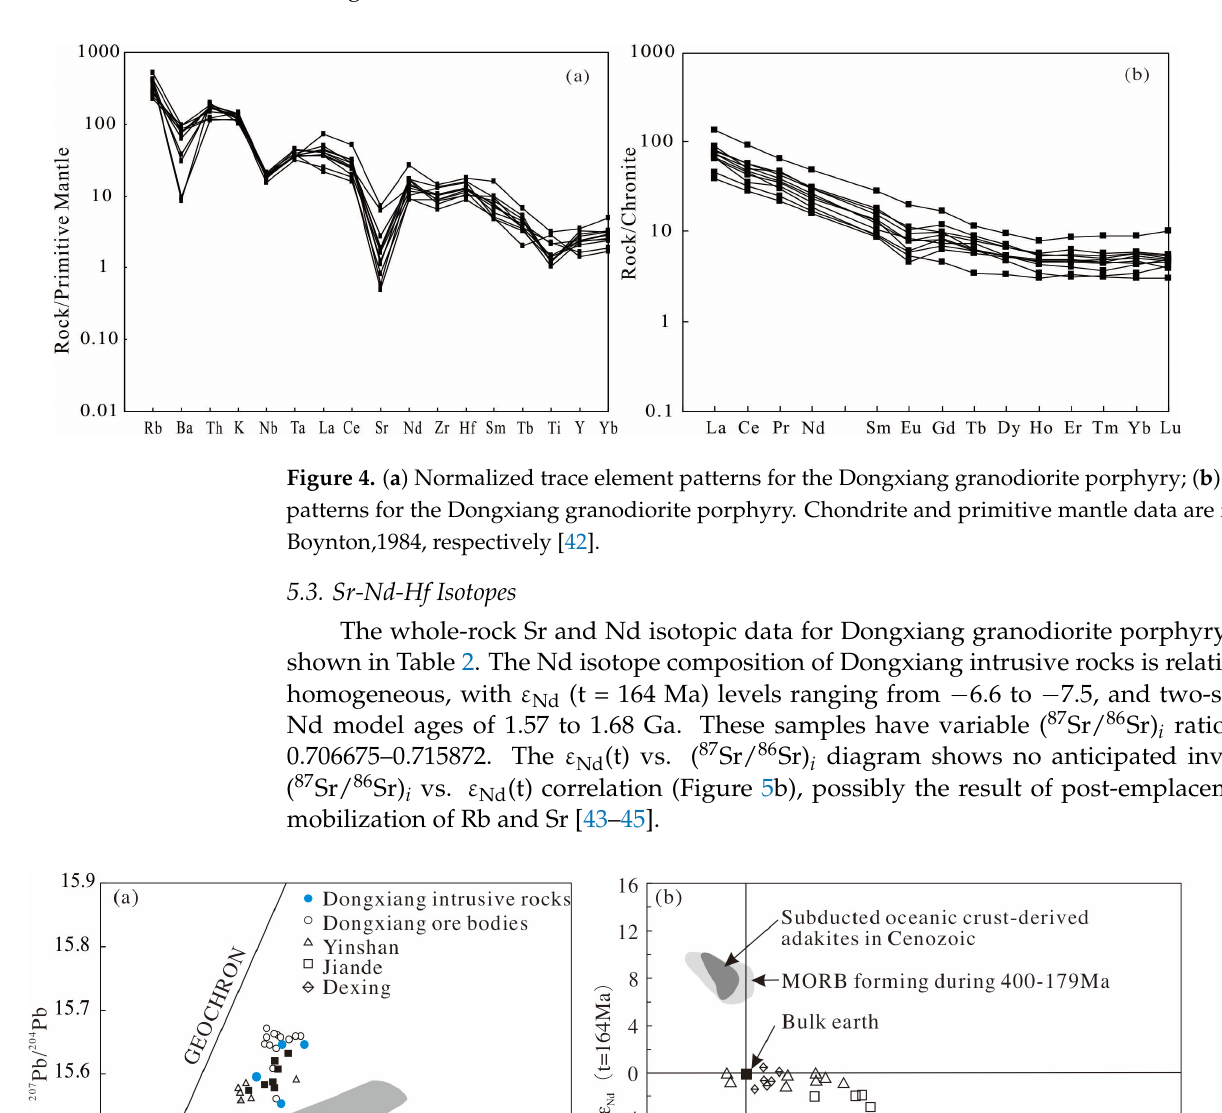
Figure 3. Total alkali vs. silica (TAS) diagram (adapted from Winchester and Floyd,1977) for the Dongxiang granodiorite porphyry [41].